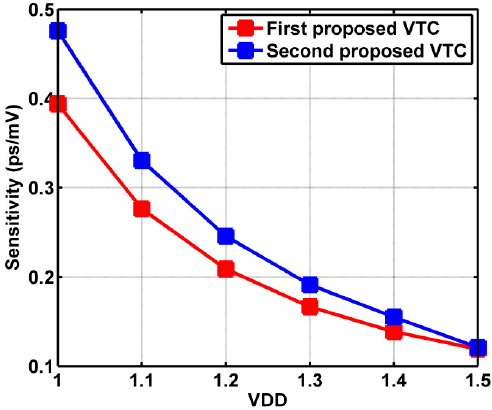
Figure 19. Sensitivity versus supply voltage for the two proposed VTC circuits.